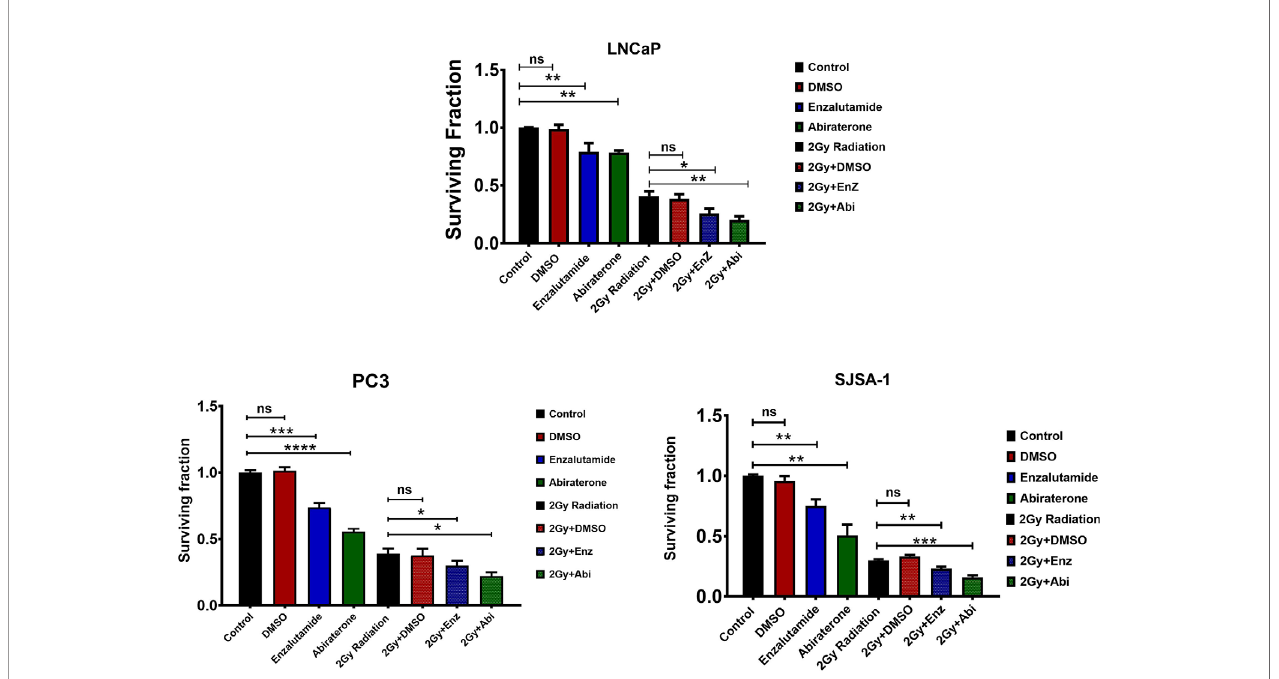
FIGURE 3 | Comparison of the combined effect of Abiraterone and Enzalutamide and DMSO as single agents or combined with 2 Gy radiation on survival fraction in androgen-sensitive LNCaPs and androgen insensitive PC3s prostate cancer models and osteoblastic bone model SJSA-1. PC3s and SJSA-1s were treated with 10 m M Abiraterone, Enzalutamide or DMSO 24 hours before radiation, while LNCaPs were treated with 200 nM due to their sensitivity. Cells were then left an appropriate amount of time to form suf fi cient colonies and any colonies of 50 cells or more counted. Each value is the mean of three independent experiments performed intriplicate (+/-SEM) andnormalizedto control. Unpaired students t-test was used for comparisonsbetween two groups. *p ≤ 0.05, **p ≤ 0.01, ***p ≤ 0.001, ****p ≤ 0.0001, ns= nonsigni fi